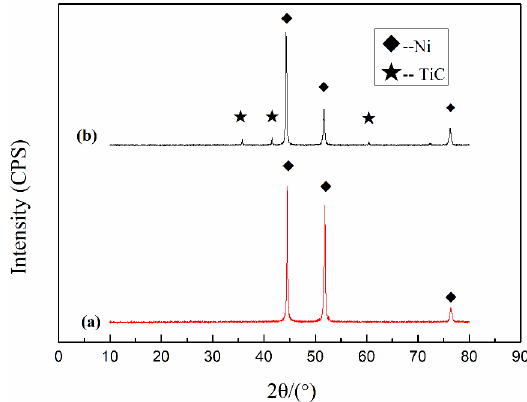
Figure 5. X-ray diffraction patterns of coatings as-plated: (a) Ni coating; (b) Ni-TiC composite coatings